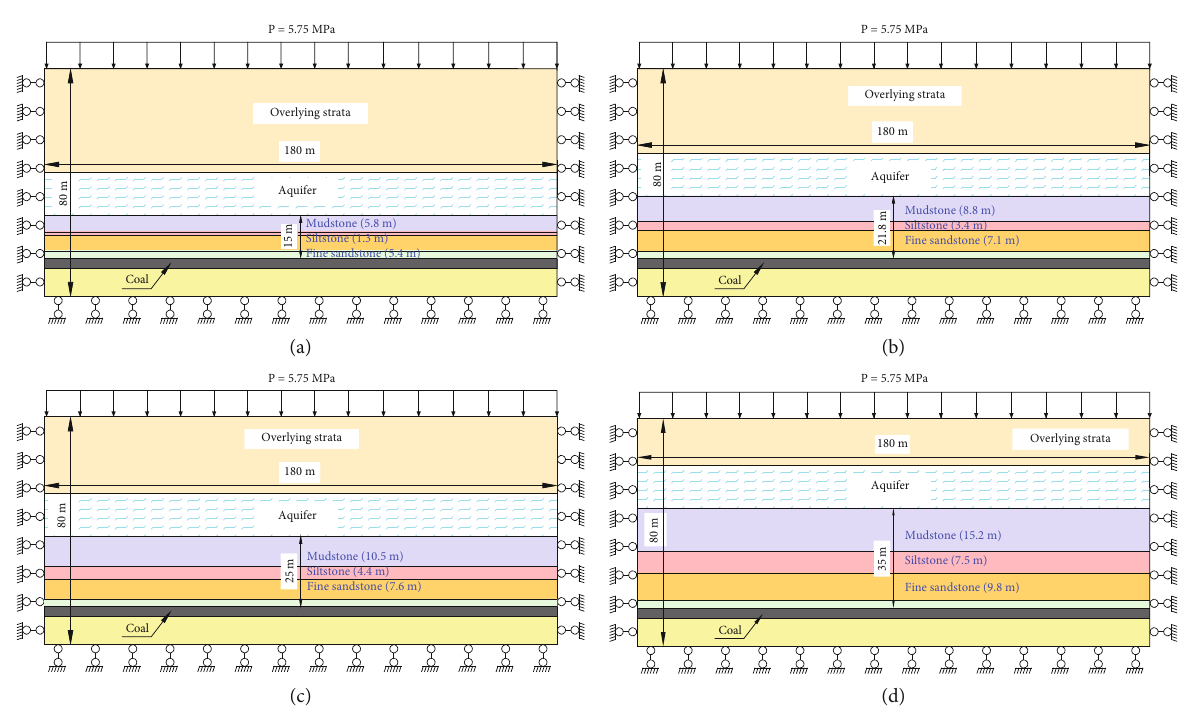
Figure 1: Numerical simulation model of KAS with di ff erent structural features: (a) single-layer soft KAS; (b) single-layer hard KAS; (c) double-layer soft/hard composite KAS; (d) four-layer soft/hard composite KAS.